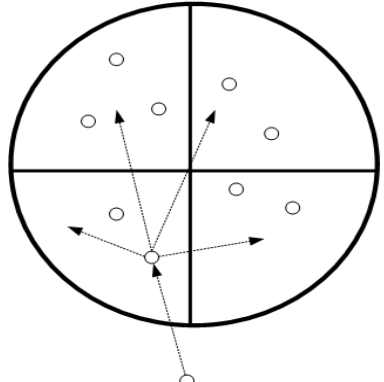
Figure 4. Recursive Geographic Forwarding Algorithm of GEAR (adapted from